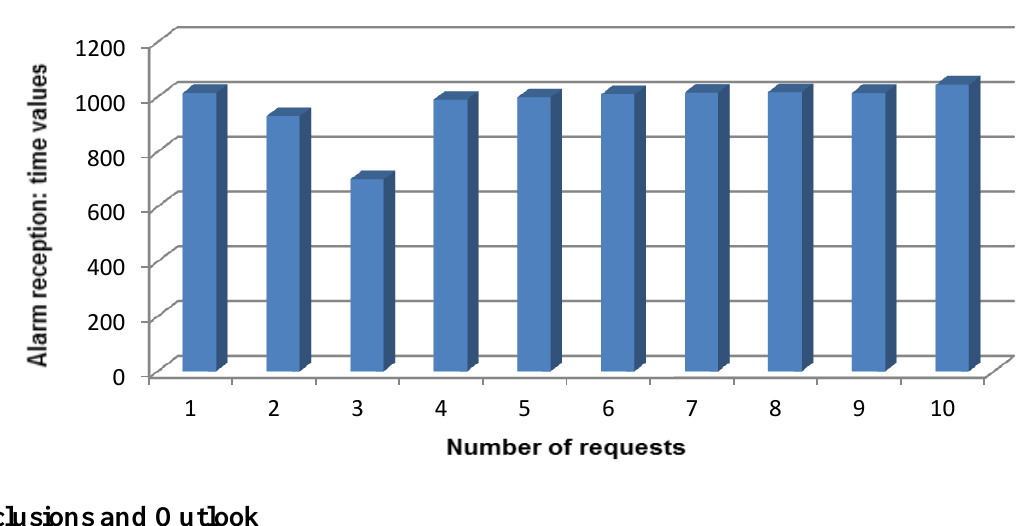
Figure 28. Time used in transferring an alarm from the node to the belt (10